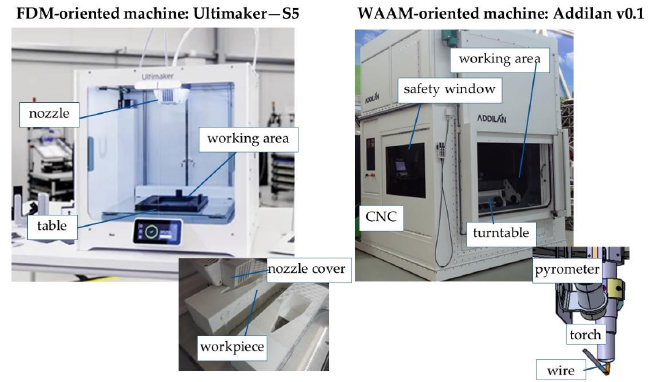
Figure 3. Machines and systems used for the manufacture of the part in FDM (Ultimaker S5) and WAAM (Addilan